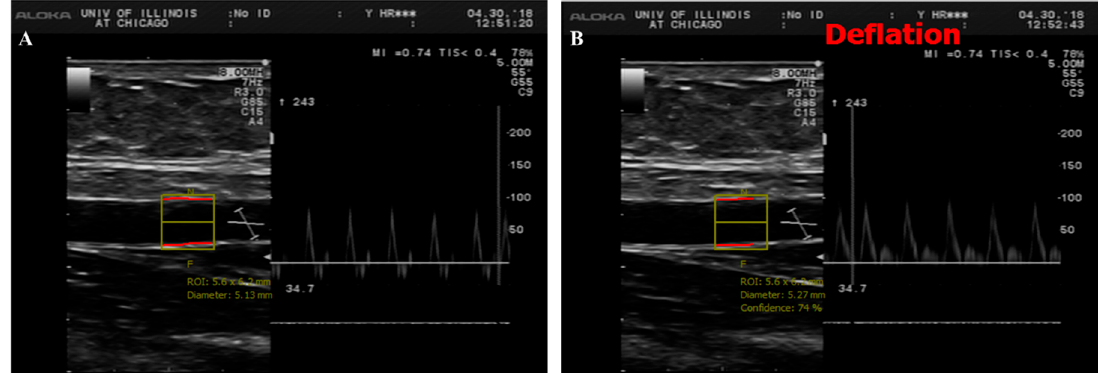
Figure 1. Duplex B-mode/pulsed wave Doppler (PWD) ultrasound of brachial artery flow-mediated dilation (FMD). This figure shows a long axis scan of brachial artery with simultaneous blood velocity profile by pulsed wave Doppler before ( A ) and after cuff deflation ( B ). For offline image analyses, a representative section of brachial artery is selected for an automated measurement of diameter. Baseline diameter (BSL) was averaged from a serial of recorded frames before cuff deflation and the maximum diameter was measured after cuff deflation during reactive hyperemia (RH).